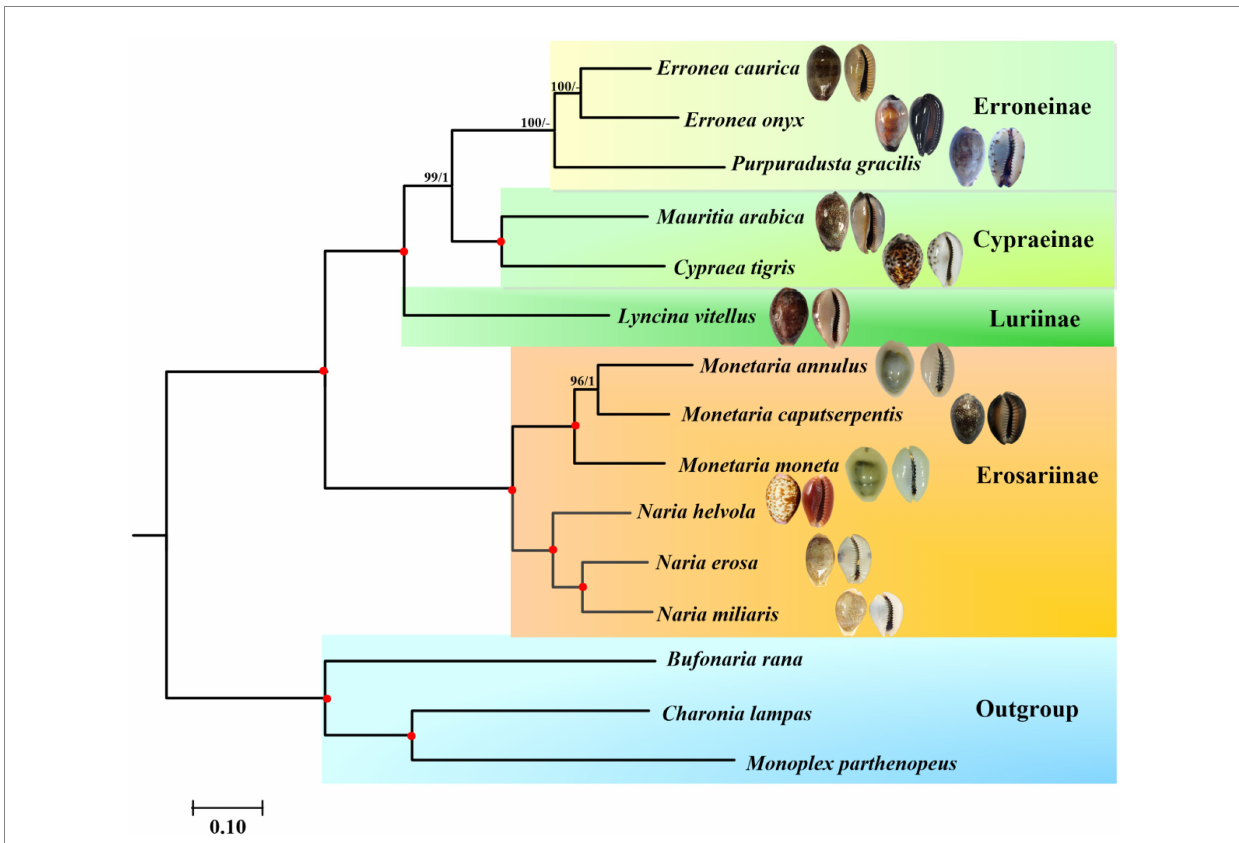
FIGURE 5 Phylogenetic relationships of Cypraeidae based on the nucleotide sequences of 13 mitochondrial protein-coding genes (PCGs) and 2 ribosomal RNA (rRNA) genes, with Bufonaria rana , Charonia lampas , and Monoplex parthenopeus as outgroups. The first number on each node is the bootstrap proportion (BP) of the maximum likelihood (ML) analysis. The second number is the Bayesian posterior probability (PP). Nodes with maximum statistical support (BP = 100; PP = 1) are marked with red solid circles.